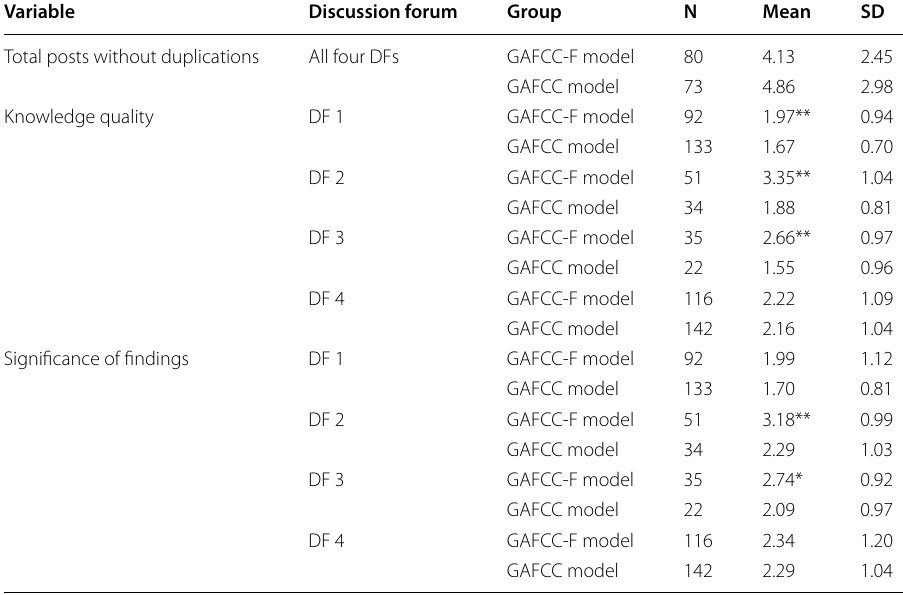
Table 2 Total number, knowledge quality, and significance of findings of posts in the two gamification design models